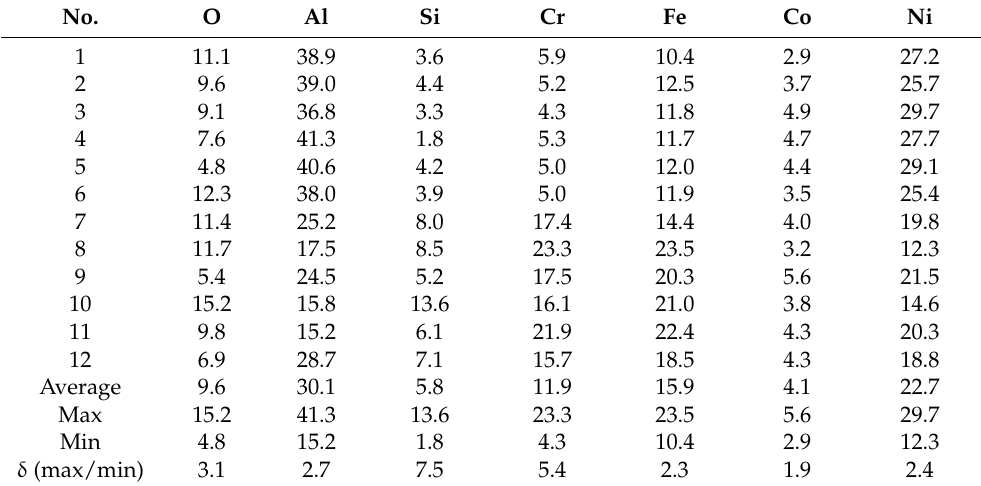
Table 3. The TEM-EDS elemental mapping outcomes (at. %) of the foil section presented in Figure 6.